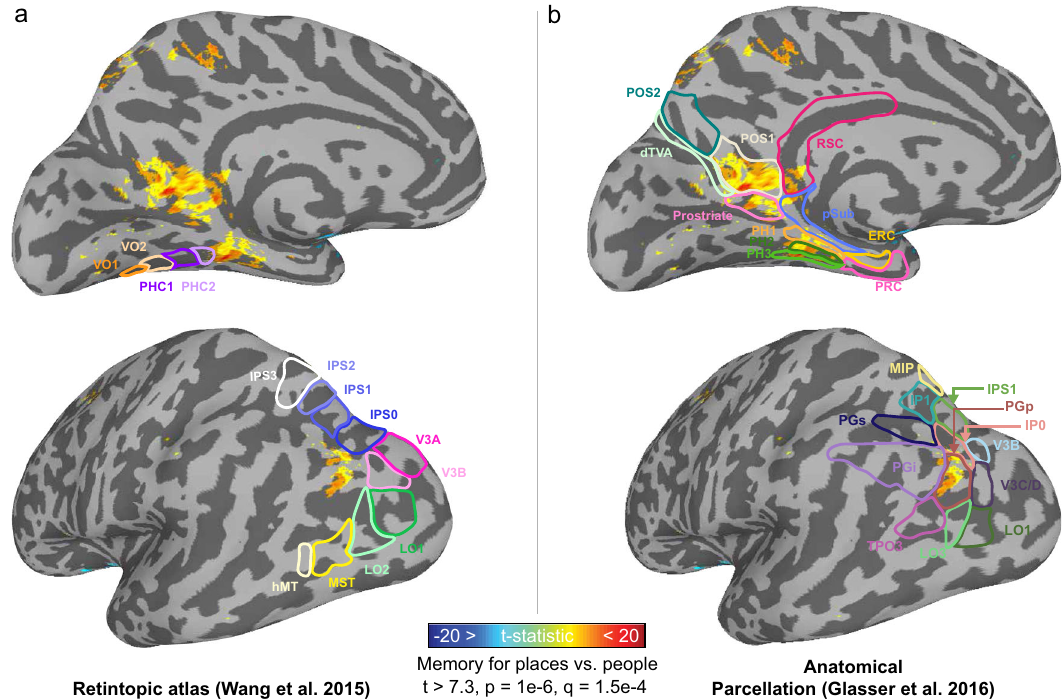
Fig. 2 Location of place-memory activity in relation to known functional and anatomical landmarks. a The place-memory areas are anterior to and have minimal overlap with retinotopic cortex. We conducted a group analysis of the place-memory localizer (place > people memory recall; thresholded at vertex-wise t > 7.3, p = 1e − 6) and compared the resulting activation to the most probable location of the cortical retinotopic maps using the atlas (overlaid) from Wang et al. (2015) 42 . The peak of place-memory activity was anterior toretinotopic maps on the lateral and ventral surfaces and there was very little overlap between place-memory activity and retinotopic maps. b The place-memory areas fall at the intersection between anatomical parcels known to be involved in visual processing and those associated with spatial memory. Comparing the peaks of place-memory activity with parcels from Glasser et al. 43 (overlaid) revealed that the place-memory areas fell at the intersection of parcels associated with visual and spatial processing. Activation maps are replotted in panels a and b to allow comparison between parcellations.